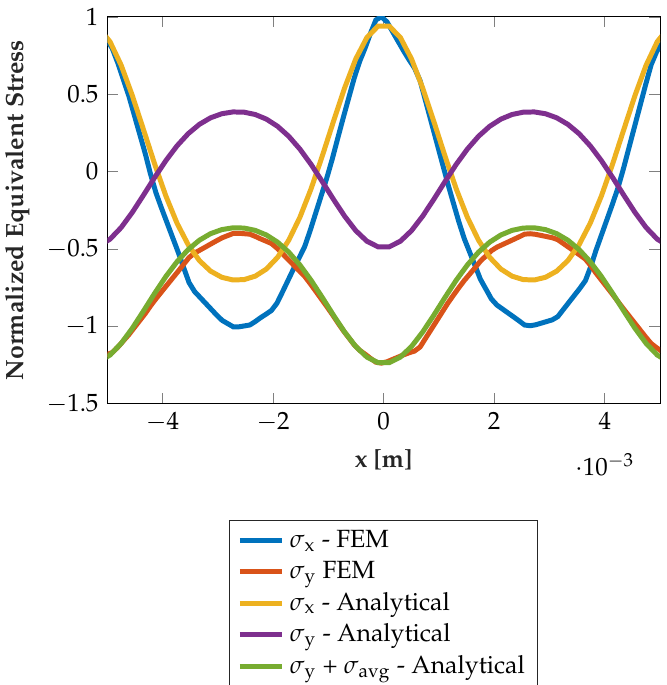
Figure 4. Comparison of stresses, determined analytically and by finite element method (FEM)